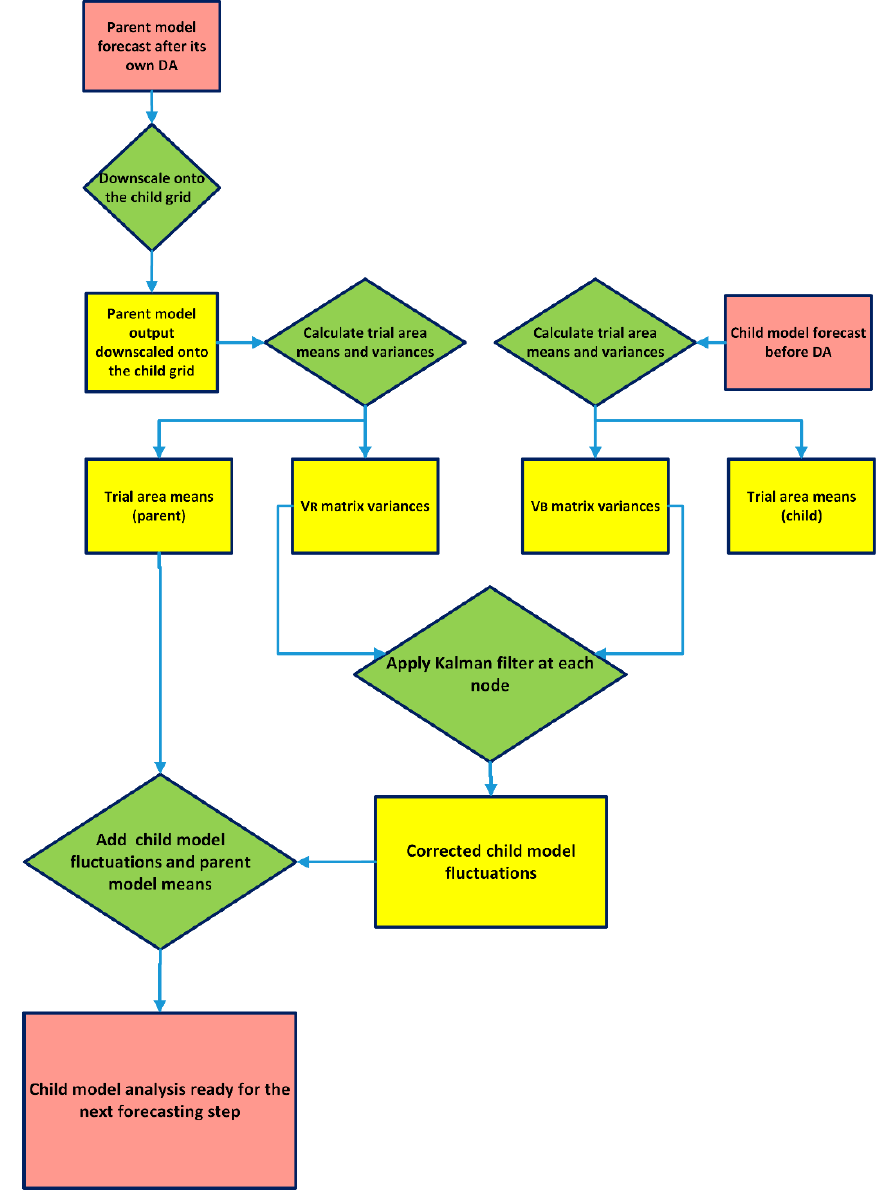
Figure 1. Workflow diagram for the NDA method showing one data assimilation cycle.